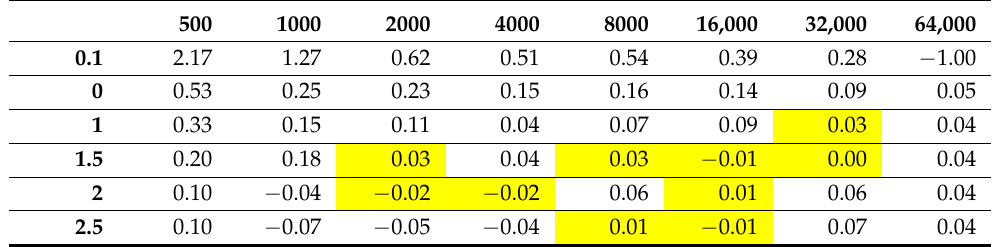
Table 6. Convergence analysis for the triangular simplified models. In yellow, the results gone to convergence are expressed in percentage in relation to the result given by the analysis and the analytical result calculated for the